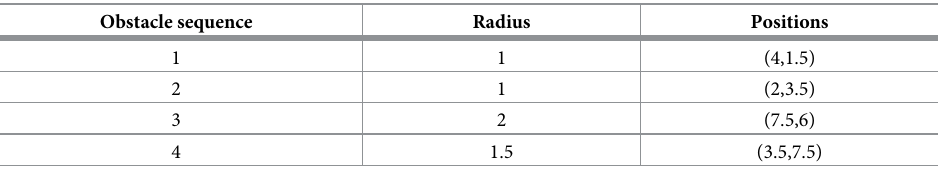
Table 3. The obstacle data in the static environment (4